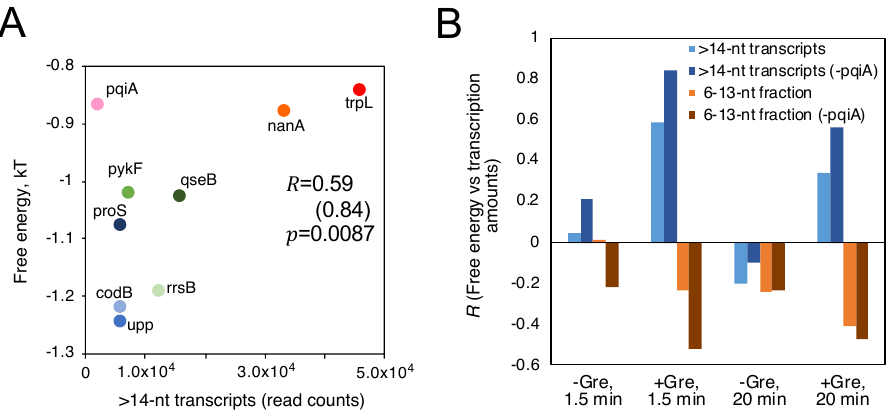
Figure 8. FEINC may predict the productivity of transcription initiation in vitro. ( A ) Positive correlation of the average FEINC (shown as free energy), which was computed for individual promoters within the interval ( − 40 bp to + 40 bp) around TSS, with the number (read counts) of long > 14 nt transcripts. Color code of 9 promoters is same as that of Figure 6A. Pearson correlation coe ffi cient R between the two variables is shown. R values except pqiA are also shown in parentheses as well as the p -value. ( B ) GreAB and incubation time with NTPs alter the positive and negative correlation trends of the free energy (FEINC) with the number of > 14-nt transcripts and the relative fraction of short 6–13 nt transcripts,